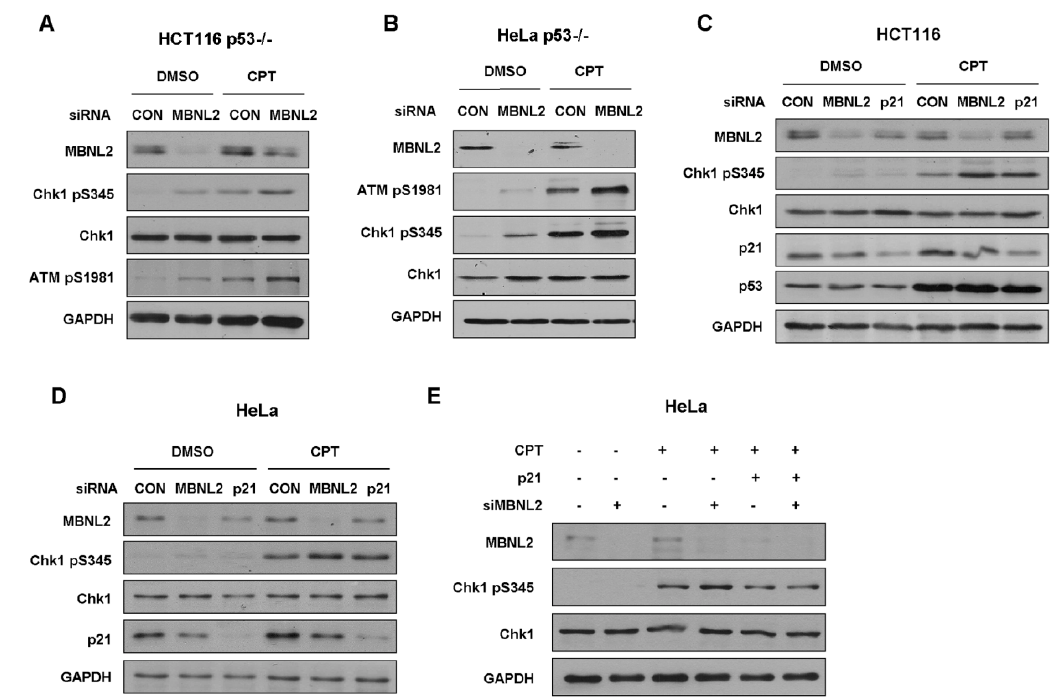
Figure 5. MBNL2 regulates the phosphorylation of Chk1 independently of p53 but through p21. ( A ) HCT116 p53 − / − or ( B ) HeLa p53 − / − cells transfected with control or MBNL2 siRNA were treated with 1 µ M CPT for 4 h or mock-treated. The samples were subjected to immunoblotting analysis of Chk1 pS345 and ATM pS1981. ( C ) HCT116 or ( D ) HeLa cells were transfected with control, MBNL2, p21 siRNA, respectively, and treated with 1 µ M CPT for 4 h or mock-treated. Samples were collected and subjected to immunoblotting analysis of Chk1 pS345. ( E ) HeLa cells were transfected with control or MBNL2 siRNA with/without p21-pGL3 plasmids and treated with 1 μ M CPT for 4 h or mock-treated. The samples were subjected to immunoblotting analysis of Chk1 pS345.